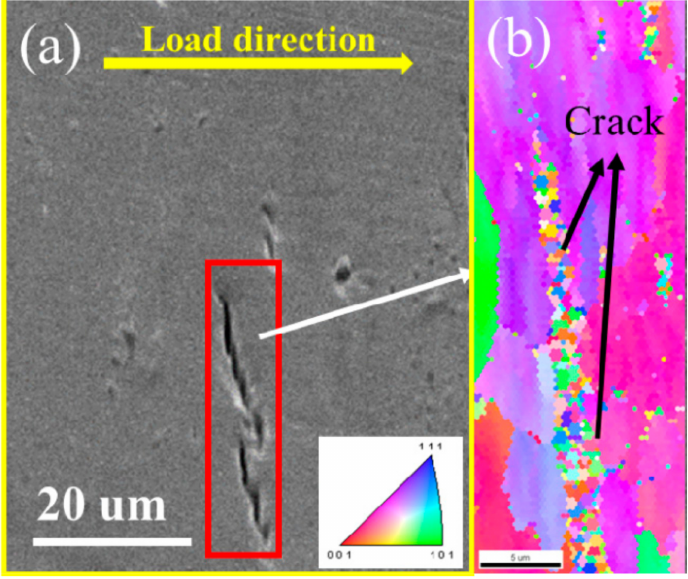
Figure 9. Microstructure of the lateral surface of a HAZ sample in the vicinity of the hydrogen-induced cracking (HIC): ( a ) Scanning electron microscopy (SEM)image and ( b ) The inverse pole figure